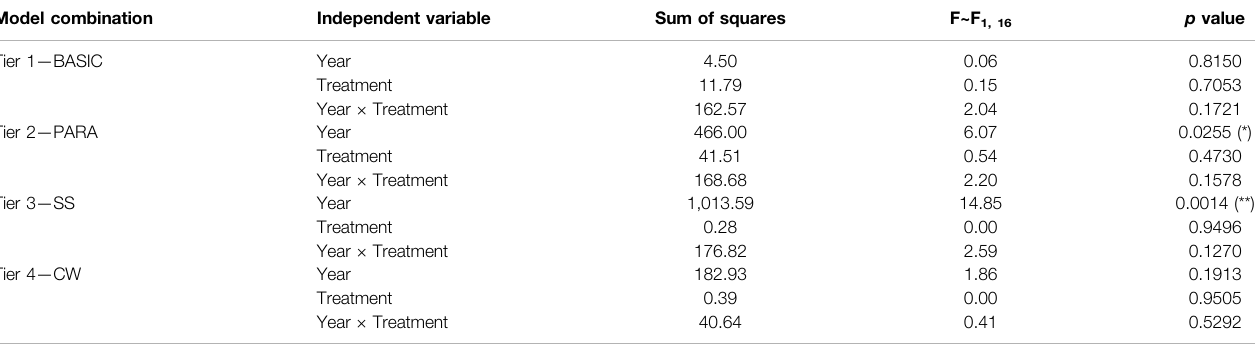
TABLE 2 | Summary of the analysis of variance (ANOVA) for the mixed-effects models fi tted on the gap- fi lled NEE for each gap- fi lling strategy. Year, treatment and their interaction are independent variables, and farm location is included as a random effect. Model